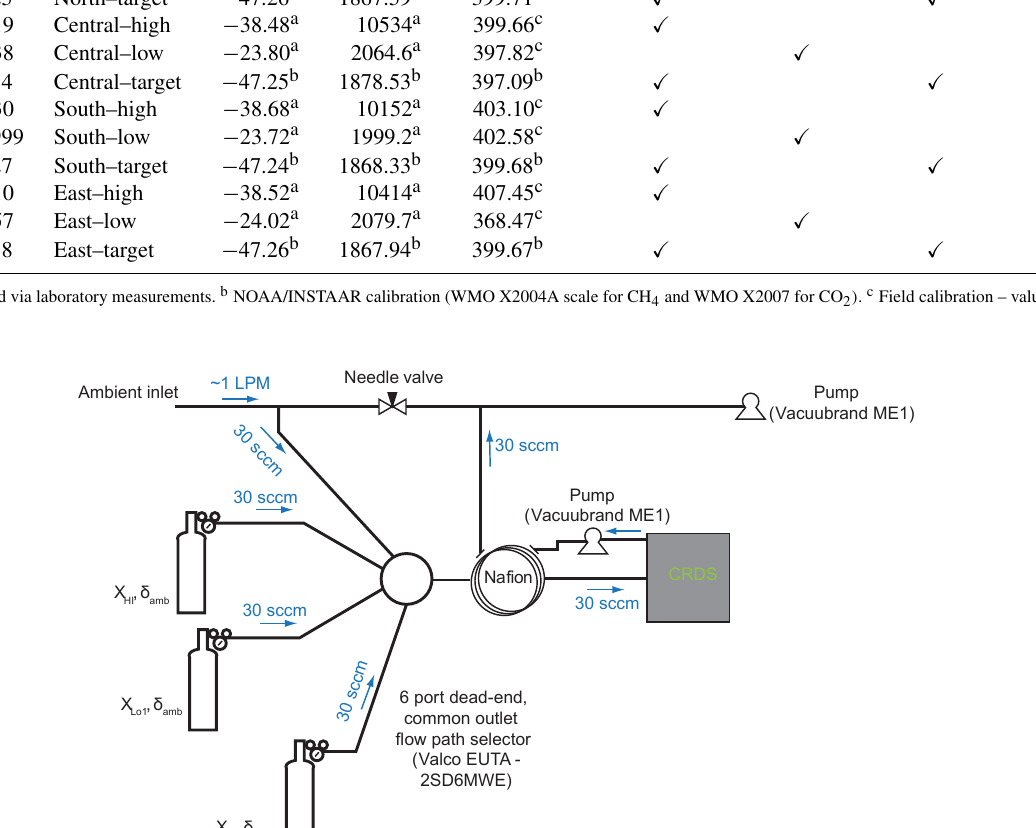
this time, the CO 2 and CH 4 mole fractions stabilized. The low and target tanks is required to achieve our target com-